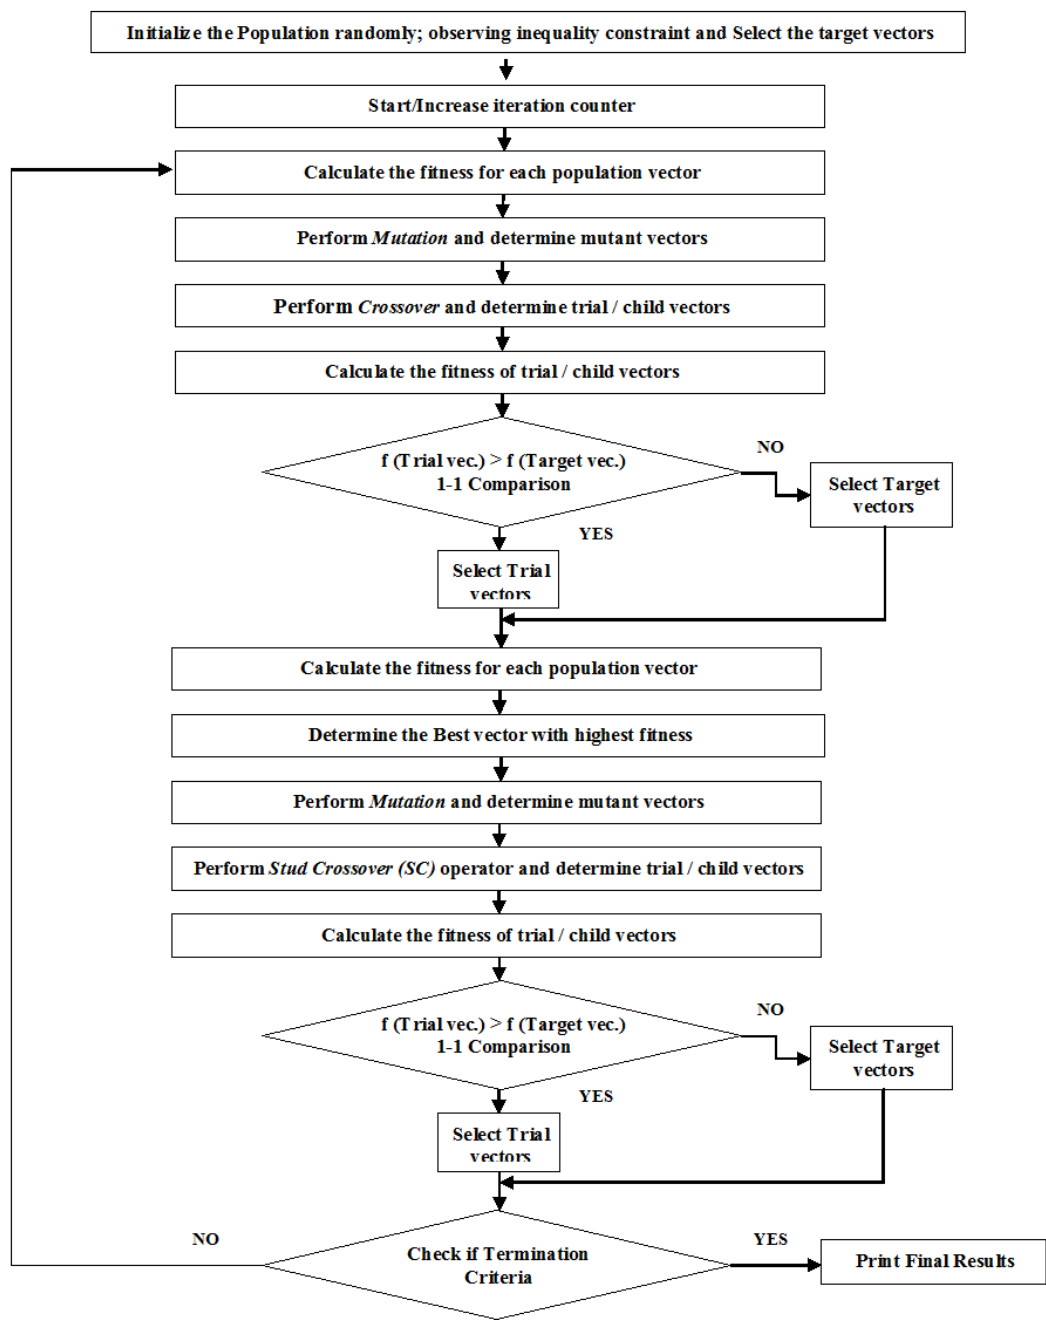
Figure 4. Flow chart of proposed Stud Differential Equation (SDE).